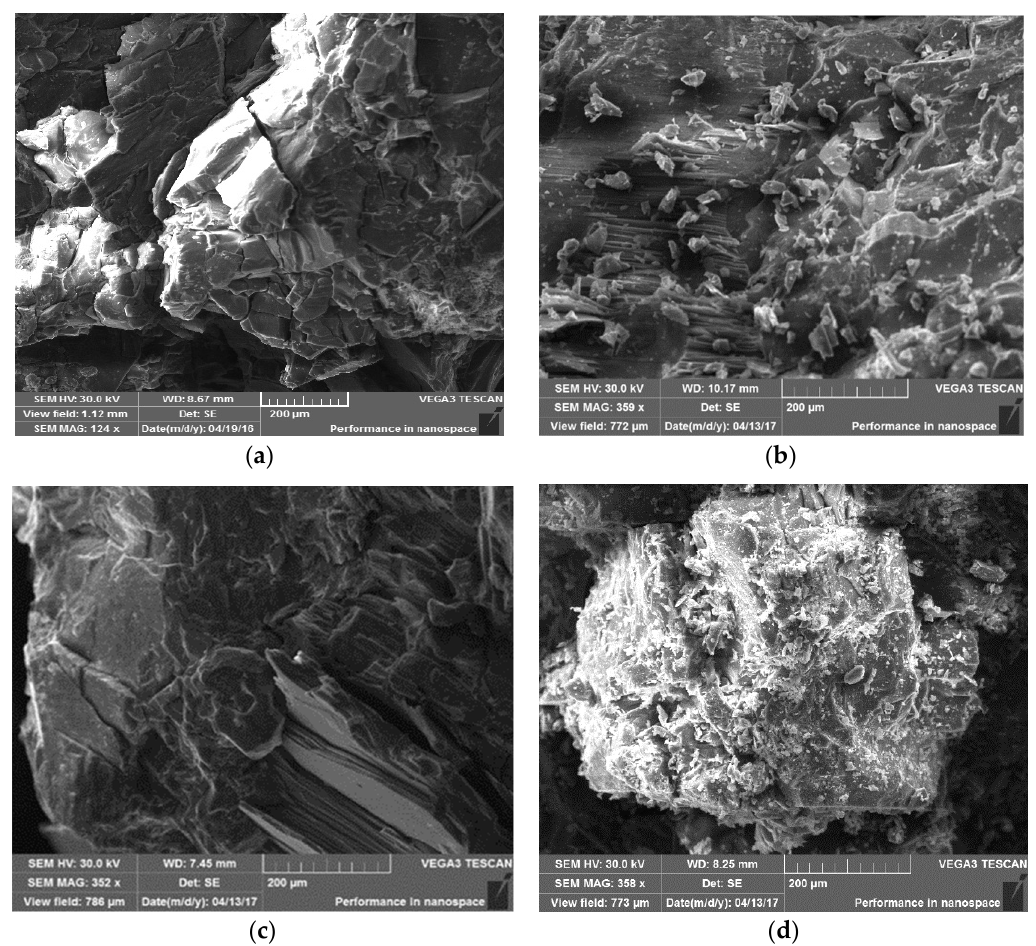
Figure 11. SEM images of tonalite in different groups: ( a ) G1; ( b ) G2; ( c ) G3 and ( d ) G4, under 200 μ m. Images of the G4 tonalite microstructure on different scales are presented in Figure 12. Figure 12a shows the intercrystalline crack, which is easily generated and leads to specimen failure. Figure 12b shows that parts of mineral exhibit irregularly shaped cavities and the number of pores and cracks has increased. An image under 500 μ m scale is shown in Figure 12c. This shows a mass of grey-white fragments on the surface of the specimen fragment. This indicates that the specimen has absorbed a large number of colloidal particles, which have filled the pores and cracks on the tonalite surface. Fang showed that the combined effect of chemical corrosion and freeze-thaw weathering generates two different types of pores: one is due to the weakening of cement, which results in larger pores and the other one is also due to the weakening of cement but with pores filled with colloidal particles. However, the composition and the effectiveness of colloidal particles were not confirmed.